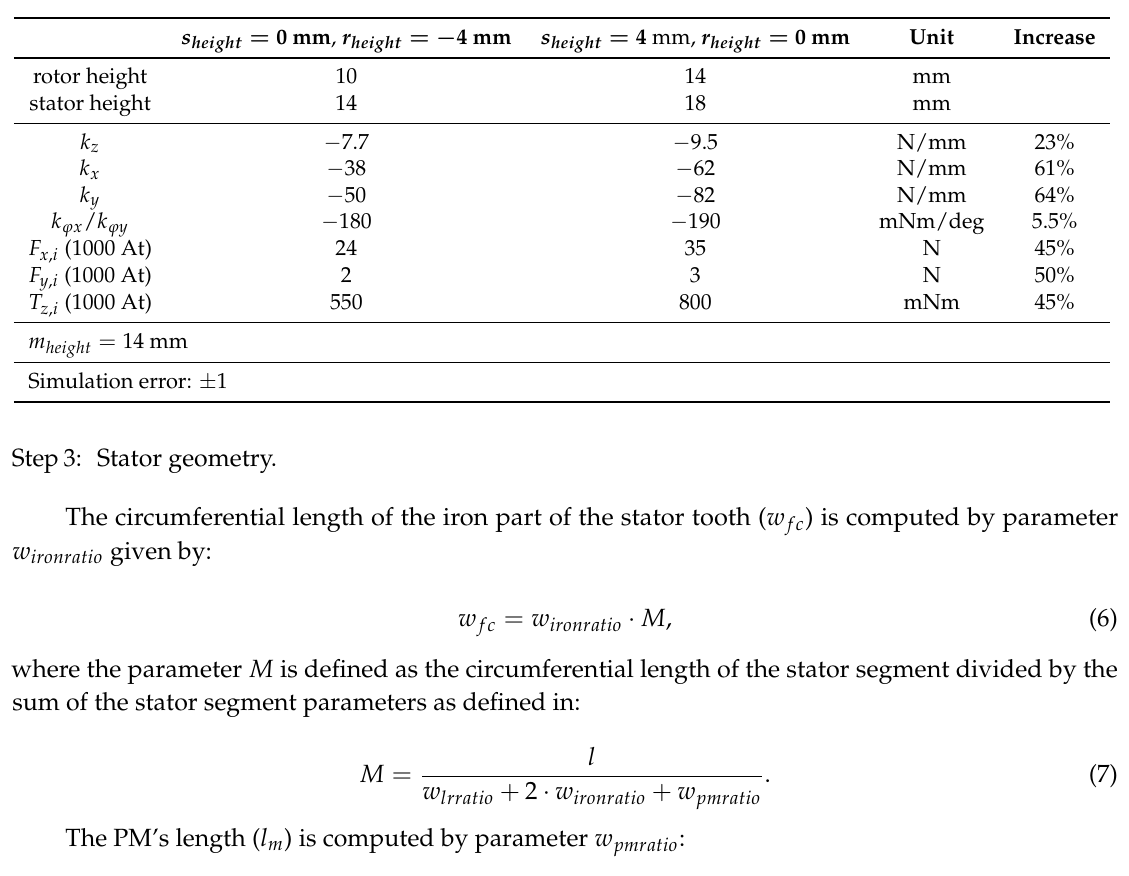
Table 6. Simulation results for decreased rotor and increased stator.